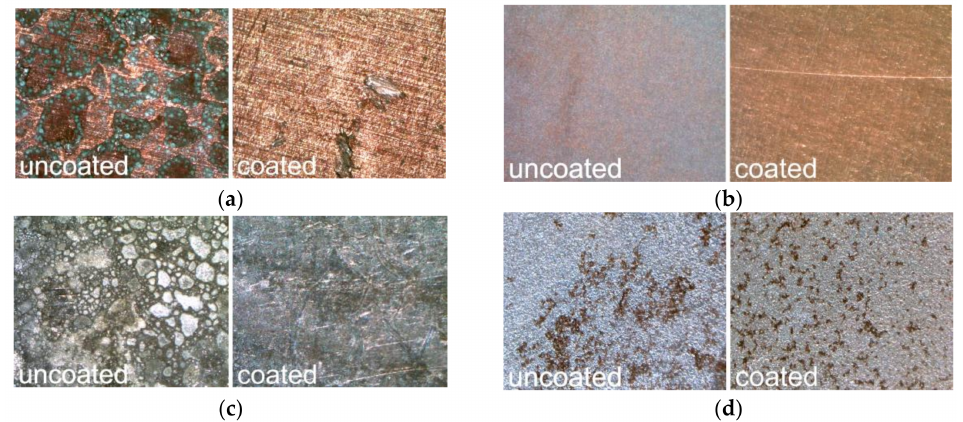
Figure 4. MO images of uncoated and coated areas of some of the samples studied after the weathering tests indicated. ( a ) Copper, x14, La(NO 3 ) 3 doped coating, Kesternich Chamber; ( b ) Bronze, x14, La(Ac) 3 doped coating, organic acids treatment; ( c ) Lead, x14, La(NO 3 ) 3 doped coating, Kesternich Chamber; ( d ) Steel, x7, La(NO 3 ) 3 doped coating, organic acids treatment.